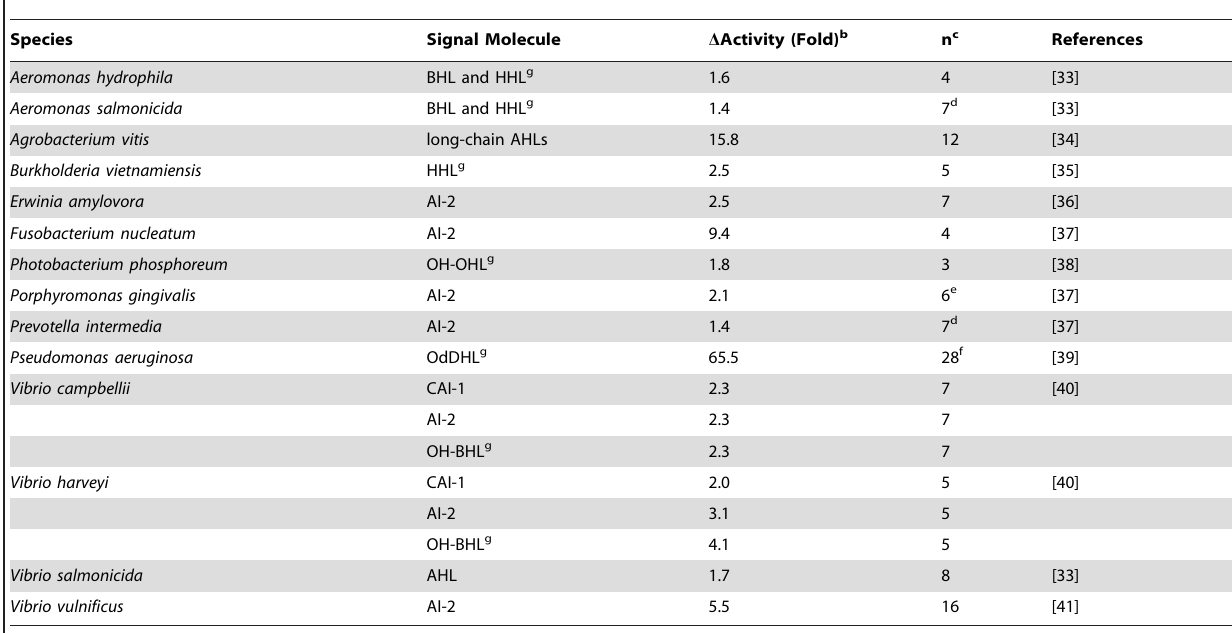
Table 1. Examples of inter-strain variability in the production of signal molecules a in different